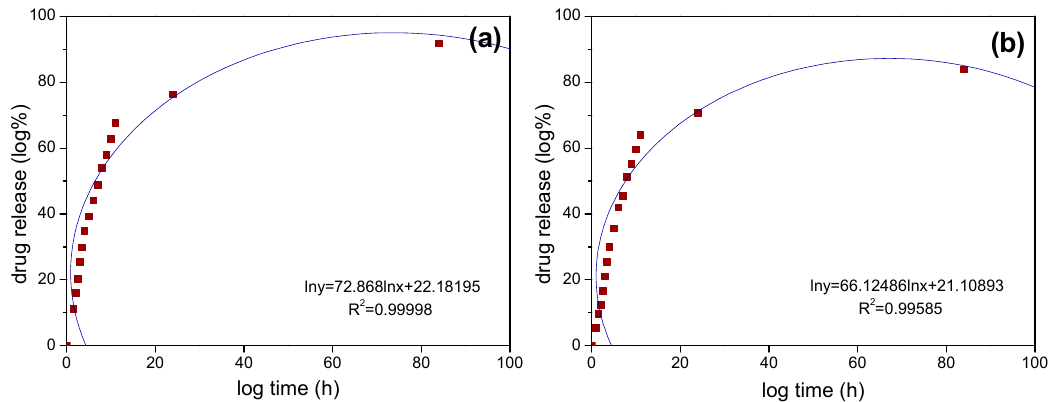
Figure 7. Drug release kinetic curves with Korsmeyer-Peppas model of ( a ) Fe 3 O 4 /SiO 2 core-shell composite nanospheres and ( b ) Fe 3 O 4 /SiO 2 /PPy core-shell composite nanospheres under stirring. Table 2. Parameters of Korsmeyer-Peppas model for IBU release under stirring.